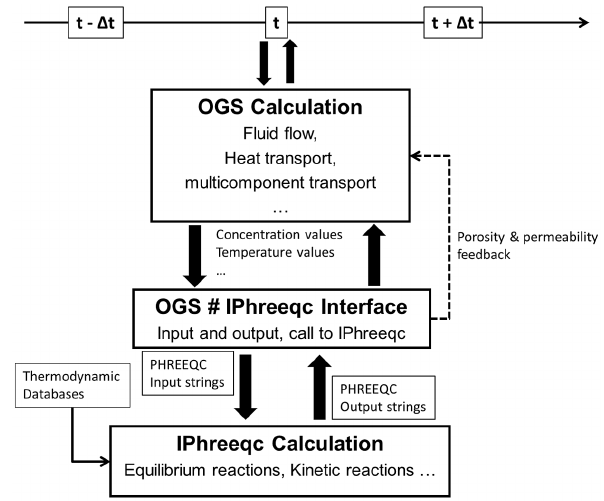
Figure 1. General concept of the coupling interface between OGS and